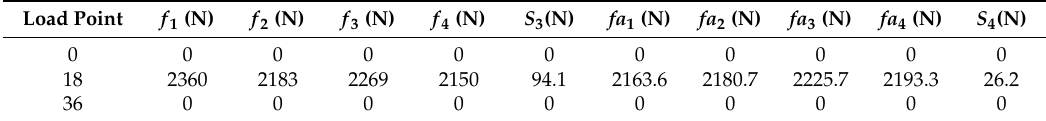
Table 7. Calculated and experimental maximum measurement module output values.